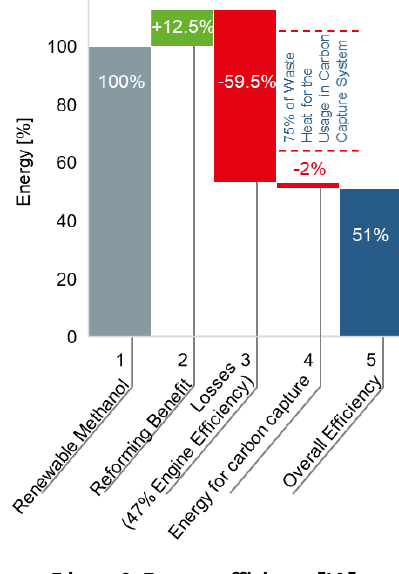
Figure 3. Energy efficiency